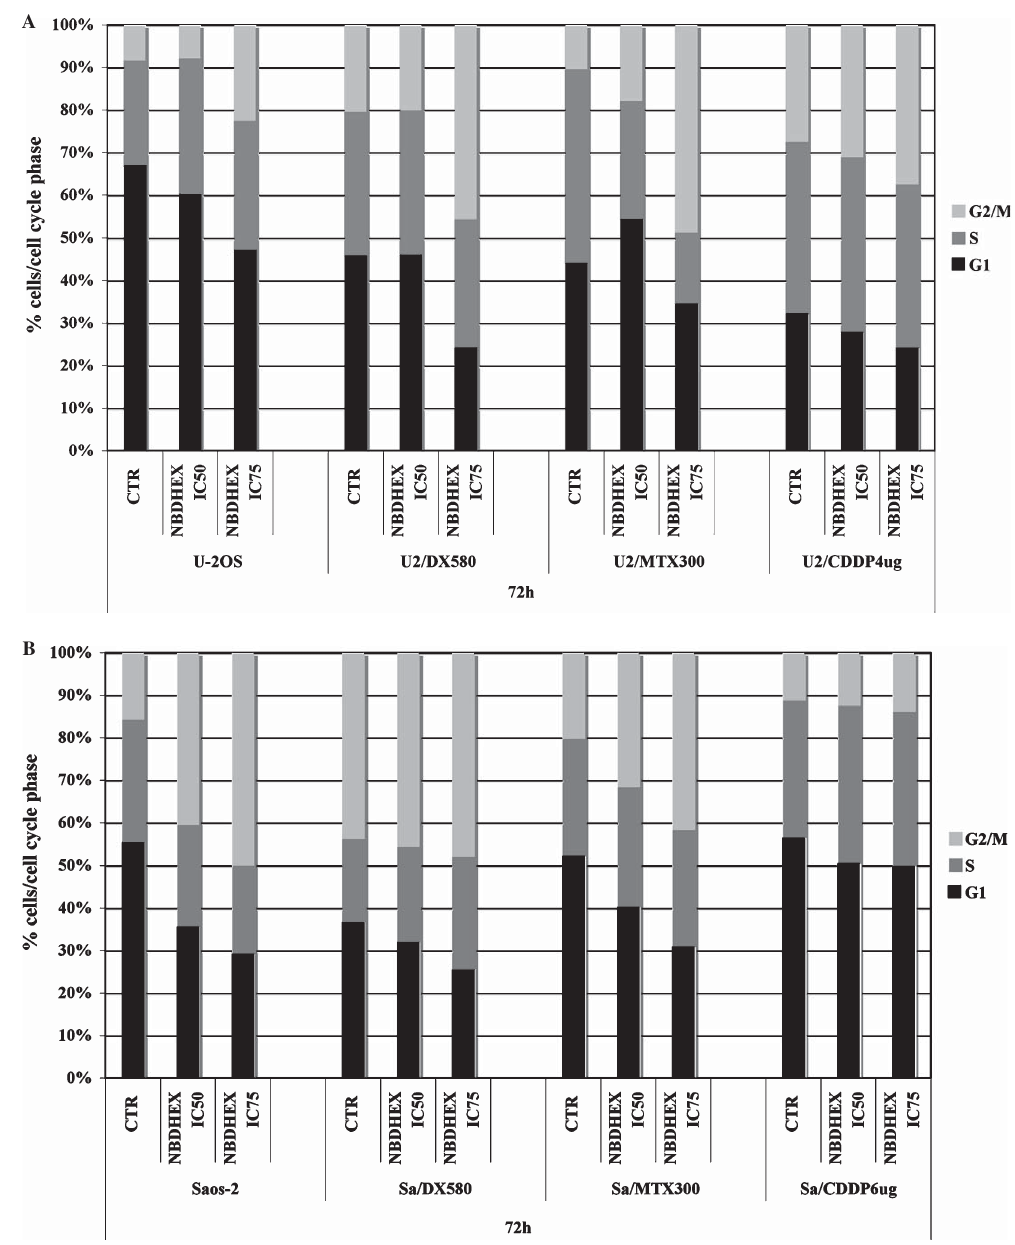
Supplementary Figure 1. Cell cycle phase perturbations induced by treatment for 72 hours with equitoxic doses of NBDHEX (corresponding to the IC50 or IC75 concentration of each cell line) in U-2OS and Saos-2 human osteosarcoma cell lines and in their drug resistant variants. Data refer to the percentage of cells for each cell cycle phase and are representative of at least two different